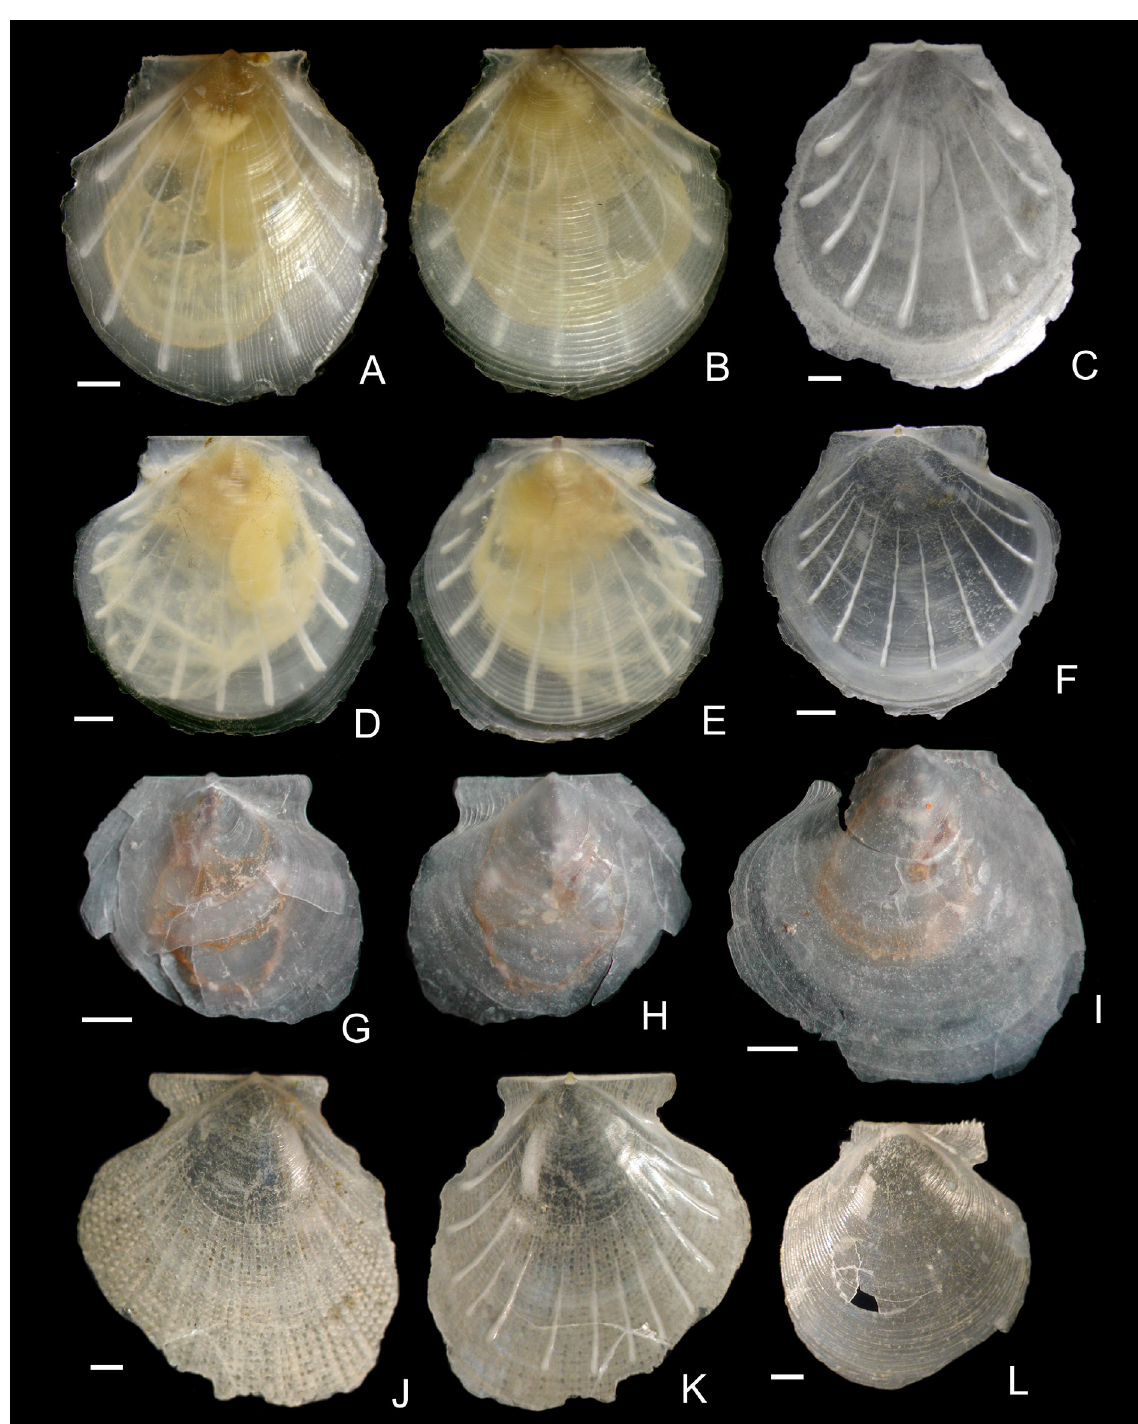
Fig. 35. Propeamussiidae. A–B . Propeamussium lucidum (Jeffreys in Wywille-Thomson, 1873), BANGAL 0711, V8, 1565 m, 8.2 mm. C . P. lucidum , BANGAL 0711, V7, 1462 m, 10.5 mm. D–F . Parvamussium propinquum (E.A. Smith, 1885), BANGAL 0711, V10, 1720 m, height 7.8 mm and 7.5 mm. G–I . Catillopecten eucymatus (Dall, 1898), SEAMOUNT 1, DW108, 1110–1125 m, 5.0 and 6.7 mm. J–K . Cyclopecten antiquatus (Philippi, 1844), SEAMOUNT 1, DW116, 985–1000 m, right valve, 10.2 mm. L . C. antiquatus , left valve, SEAMOUNT 1, DW108, 8.0 mm. Scale bars = 1